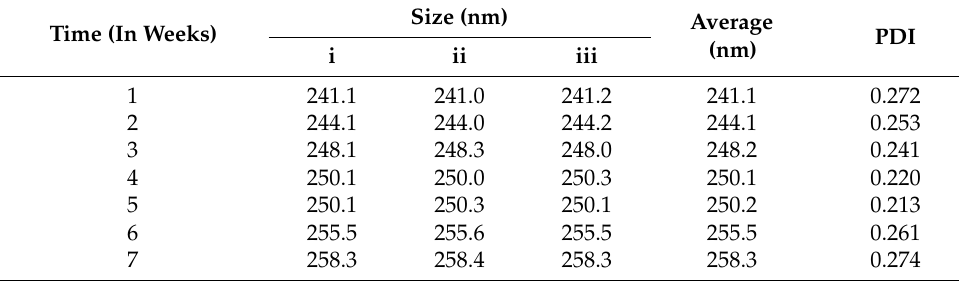
Table 4. Particle size of BCA-LDH-C for 7